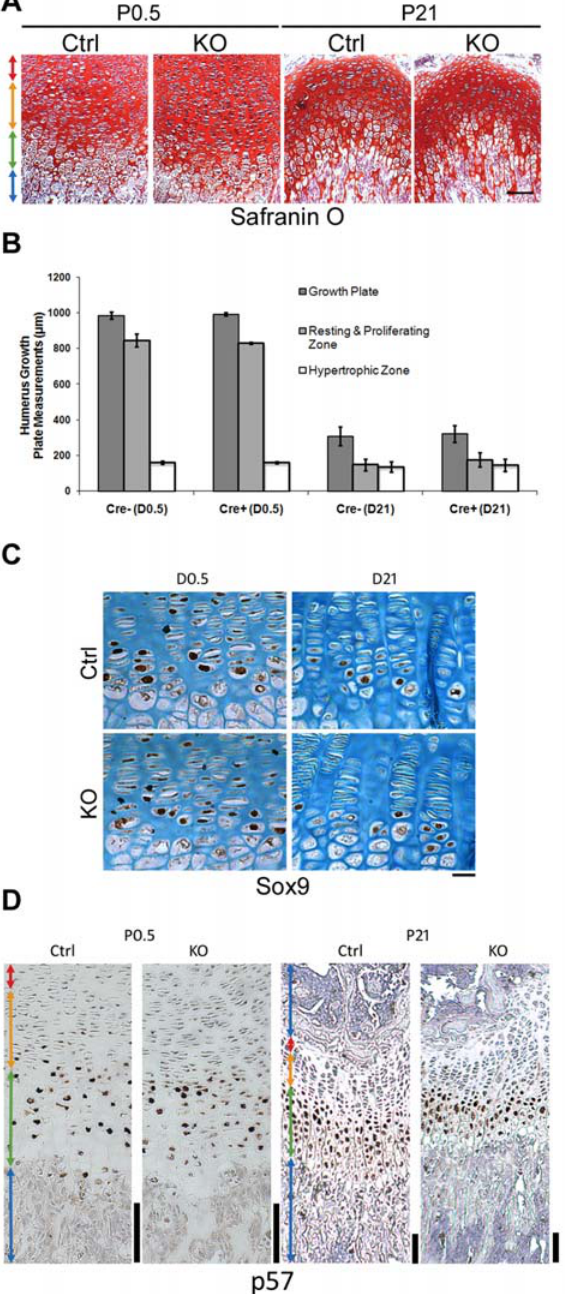
Figure 4. ATRX-null growth plates are indistinguishable from controls. (A) Growth plate sections from control and Atrx Col2Cre mice at P0.5 and P21 were stained with safranin-O/Fast green, demonstrating unaltered growth plate architecture and morphology in mutant mice. Scale bar: 100 m m. (B) No significant difference in the length of the resting, proliferating or hypertrophic zones could be detected between genotypes at birth or weaning (N=3 littermate pairs; two-tailed T-test). Error bars depict standard error of the mean (SEM). (C) Expression of Sox9, an early chondrocyte differentiation marker expressed in resting and proliferating chondrocytes, is not altered in the absence of ATRX at P0.5 or P21. Scale bar: 50 m m. (D) Immunohistochemistry for the differentiation marker p57 reveals that ATRX loss has no effect on the proportion of chondrocytes reaching terminal differentiation. Scale bar: 100 m m.